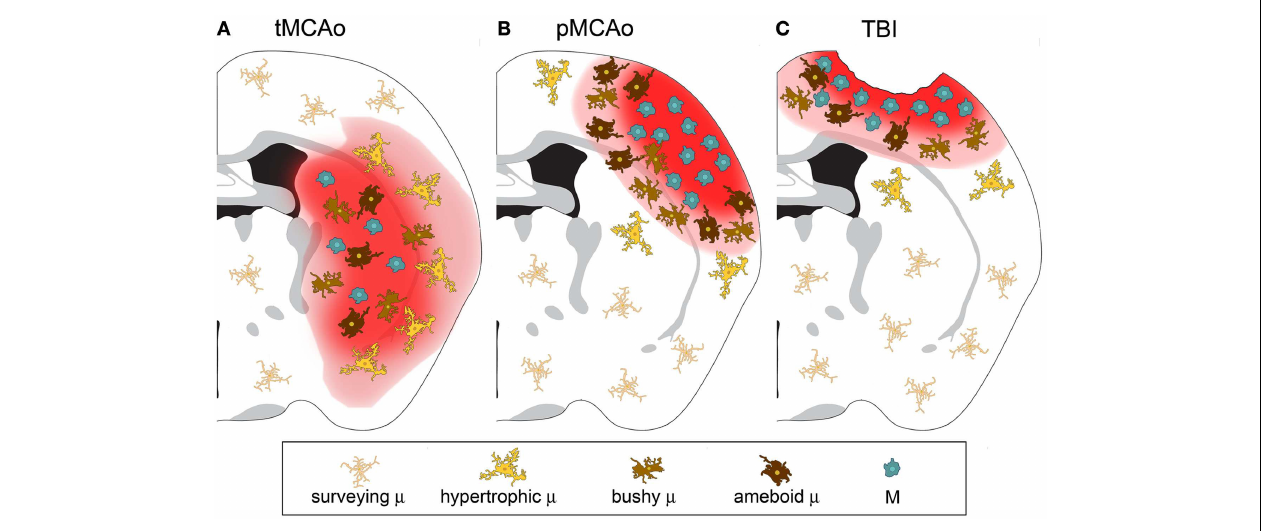
artery occlusion (pMCAo) no µ cells are present in the lesion core where there is high M infiltration. Bushy µ cells surround the lesion core. (C) The distribution is similar after traumatic brain injury (TBI). M are recruited to the lesioned tissue close to its lesion edge, while bushy and hypertrophic µ cells populate more distant